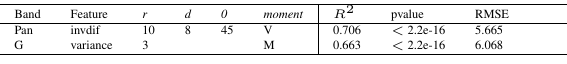
Table 7: Best image features for age prediction ( n = 184 )